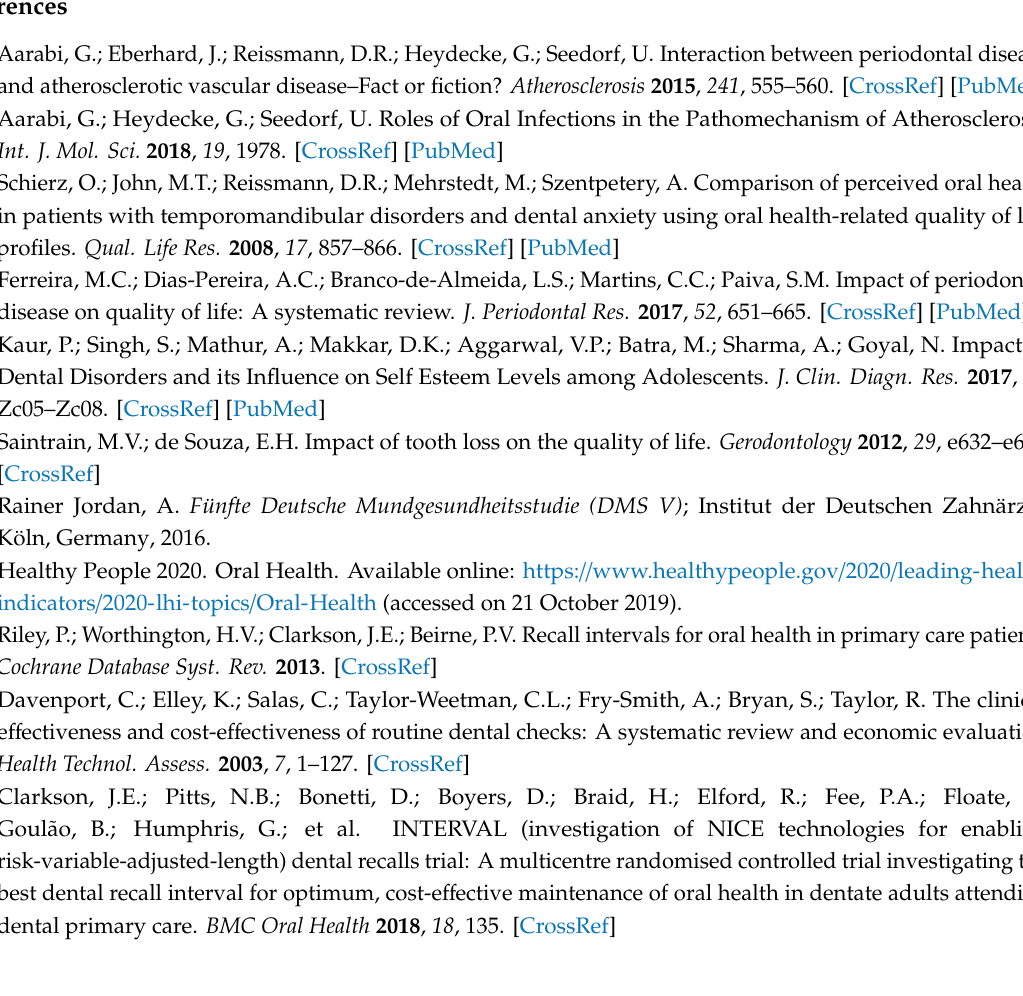
Figure S1: Distribution of dental visits; Table S1: Determinants of frequent dental visits (0 = Non-frequent dental visits; 1 = Frequent dental visits; cut-o ff at the highest decile). Results of logistic regressions; Table S2: Determinants of frequent dental visits (0 = Non-frequent dental visits; 1 = Frequent dental visits; cut-o ff at the highest quartile). Results of logistic regressions; Table S3: Determinants of frequent dental visits (0 = Non-frequent dental visits; 1 = Frequent dental visits; cut-o ff at the highest 5%). Results of logistic regressions; Table S4: Determinants of frequent dental visits (0 = Non-frequent dental visits; 1 = Frequent dental visits). Results of multiple logistic regressions; Table S5: Determinants of frequent dental visits (0 = Non-frequent dental visits; 1 = Frequent dental visits). Results of multiple logistic